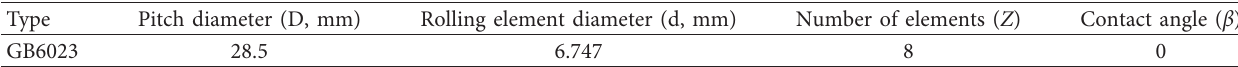
Figure 5: 8791A250 accelerometer setting. Table 1: The parameters of